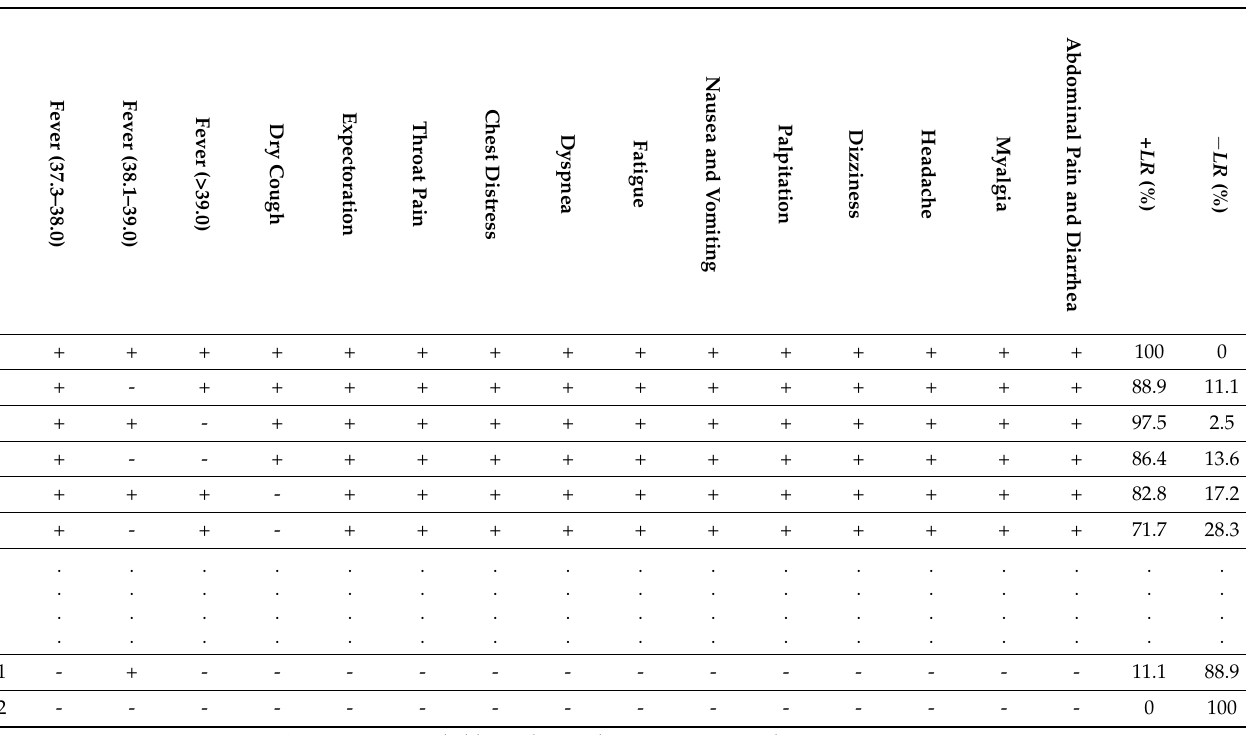
Table 7. All the probable predictions and explanations for COVID-19 patients according to their